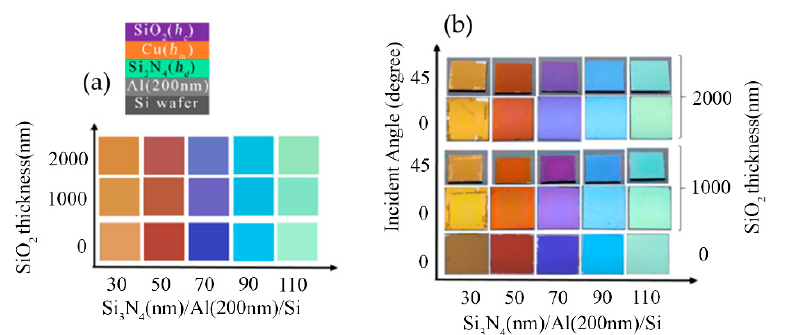
Figure 4. ( a ) The measured pseudo colors and ( b ) the camera images of the SiO 2 (1000–2000 nm)/Cu ( h m )/Si 3 N 4 ( h d ) / Al structure.